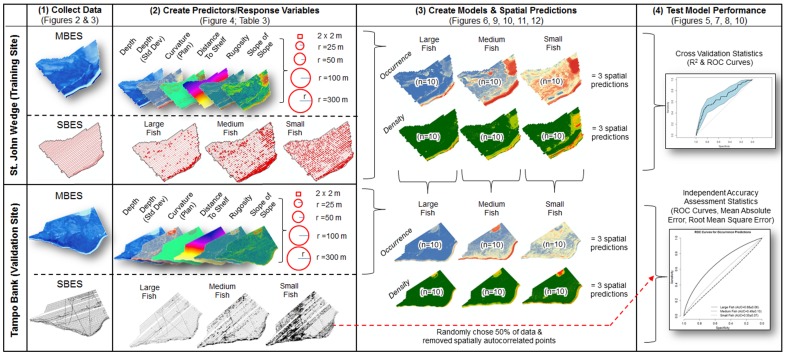
Diagram of modeling process.Steps used to train and validate the Boosted Regression Tree models developed from the SBES and MBES datasets.